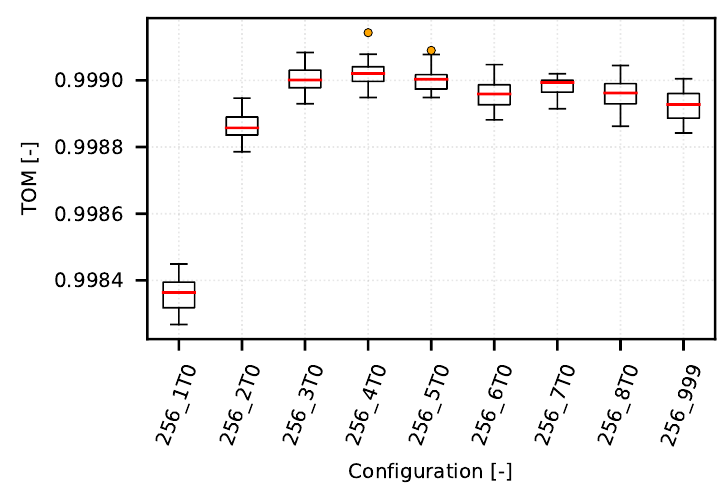
Figure 11. CSMA/CA—example of optimization curve (mean quantile 0.999 of 256_5T0